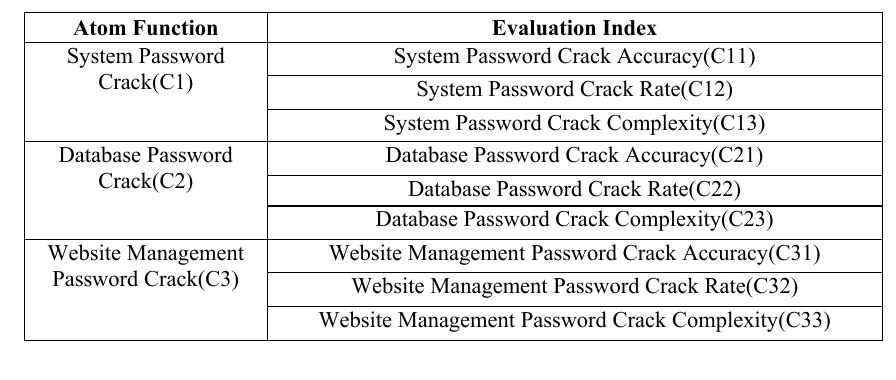
Table 1. Password crack